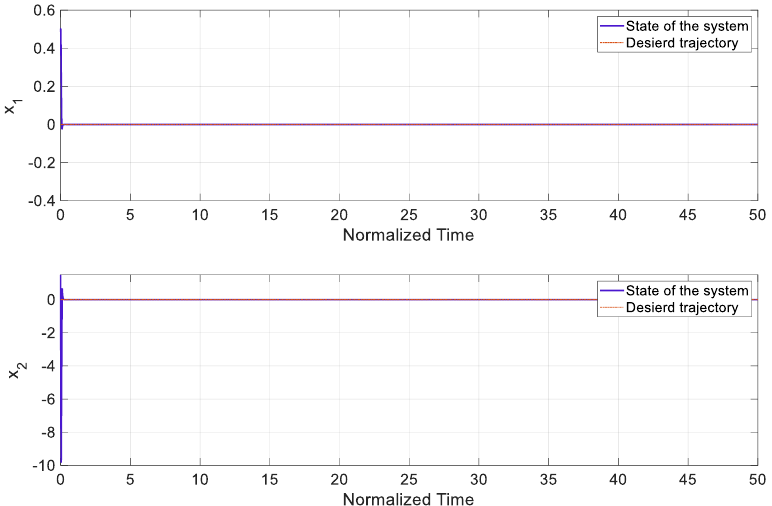
Figure 4. The states of the CNT with uncertain parameters using the suggested control technique method.